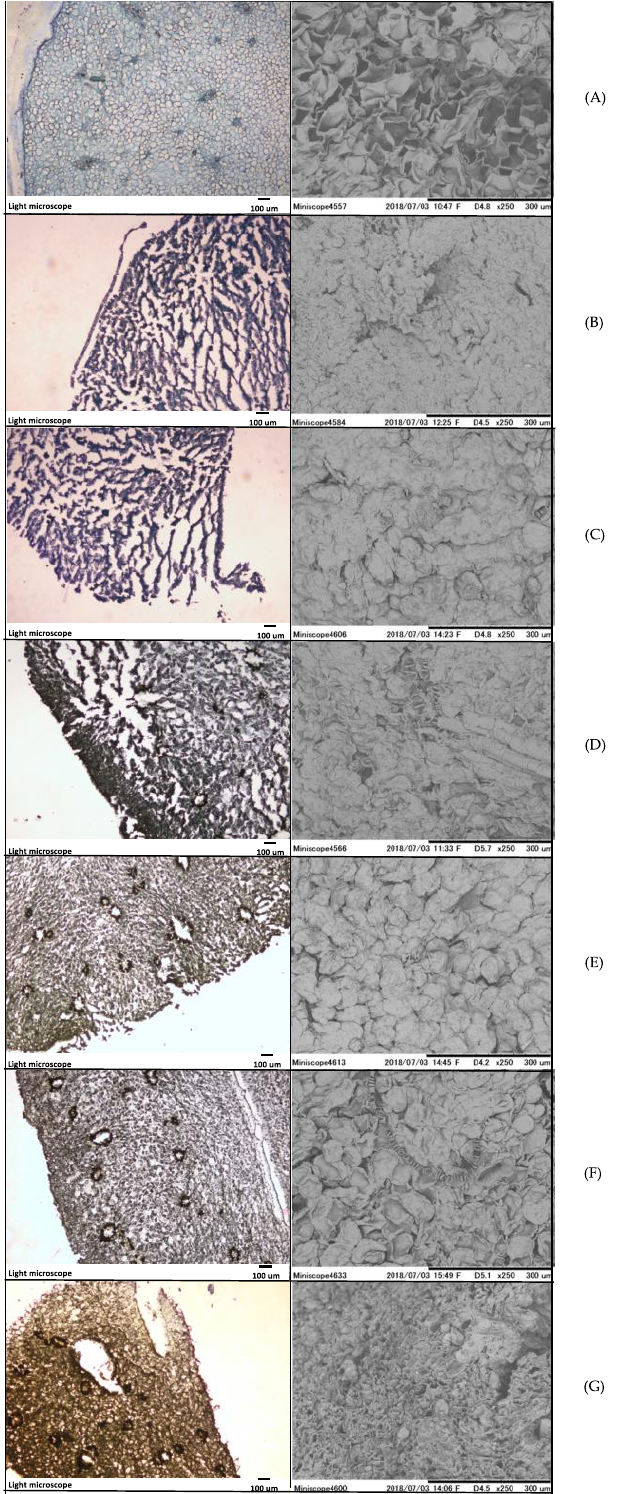
Figure 3. The cross-section of garlic scape under light microscope and electron microscope observa- tion: ( A ) fresh garlic; ( B ) BG1, ( C ) BG2, ( D ) BG3, ( E ) BG4, ( F ) BG5, and ( G ) BG6, which were processed from FG of different iMC (72.60%, 66.78%, 59.99%, 56.44% 51.15% and 49.95%, respectively).